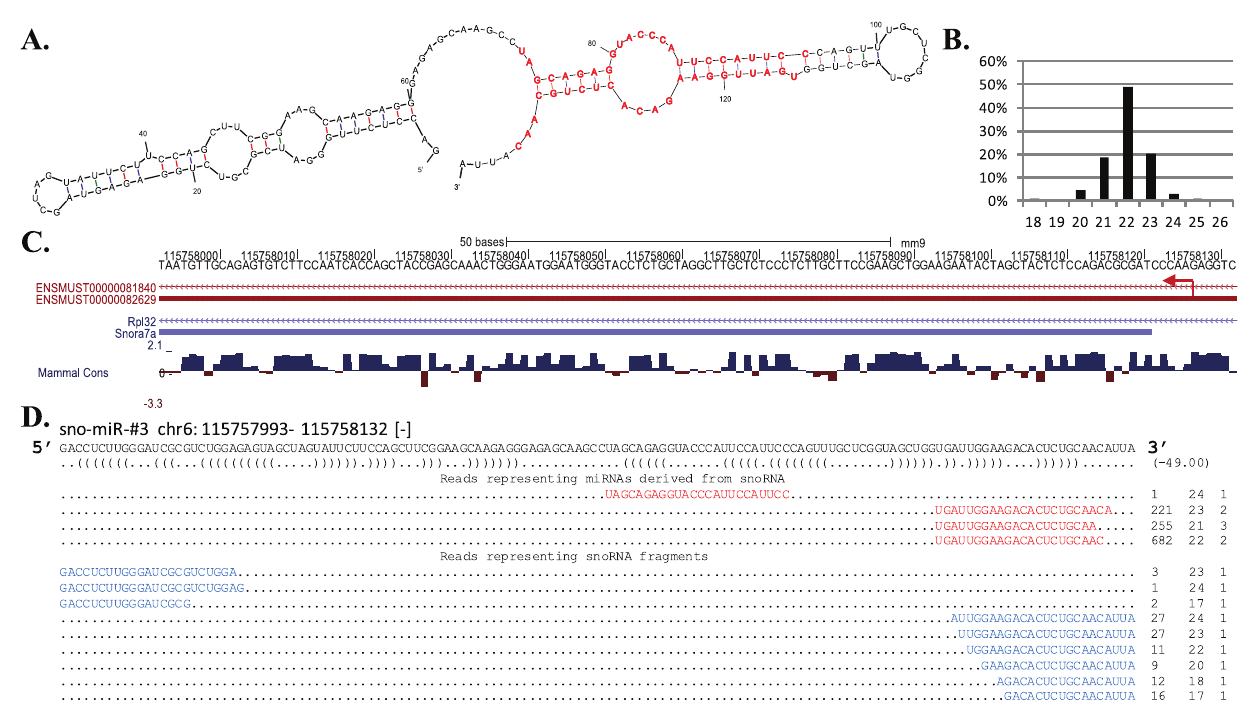
Figure 2. A murine miRNA, sno-miR- # 3, derived from snoRNA Snora7a. (A) Folding structure of the snoRNA carrying a hairpin shaped structure. The miRNAs (annotated in red) on 5 9 and 3 9 arm form a duplex with 1-nt 3 9 overhang. (B) Length distribution of the total reads mapped to the snoRNA, which peaked at 22-nt. (C) snoRNA gene annotated in Ensembl and RefSeq annotations. Snora7a resides within an intron of Rpl32. The red arrow indicates the orientation of the snoRNA gene. The conservation score by PhyloP shows how well each base pair is conserved in mammals. (D) Alignment of reads representing miRNA sequences (red) and snoRNA fragments (blue), which appeared in Dicer- and Dgrc8-knockout mice.